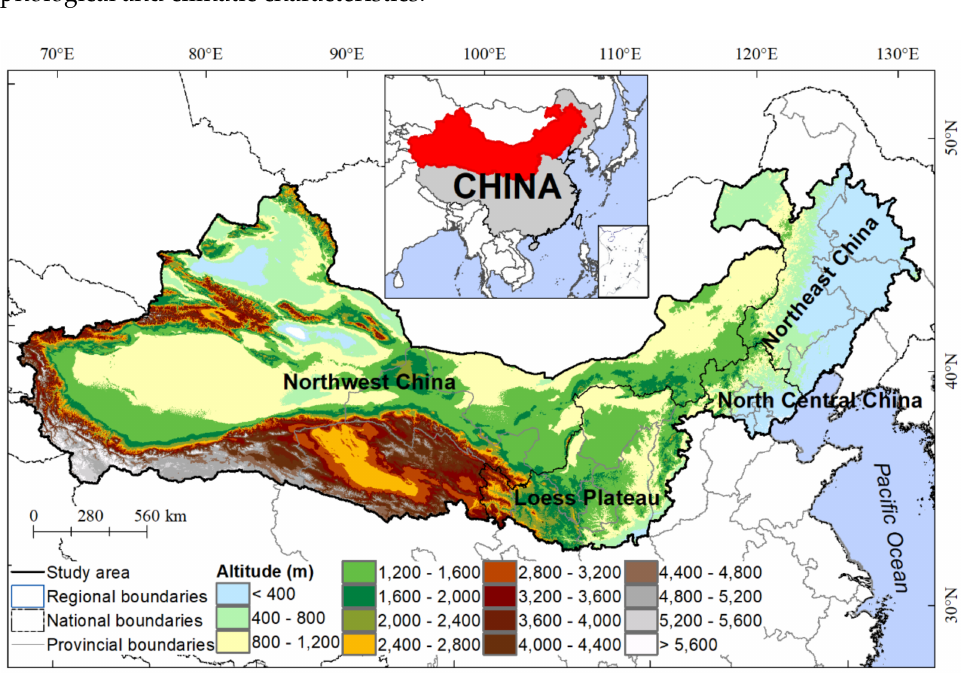
Figure 1. Location of China’s Three-North Region